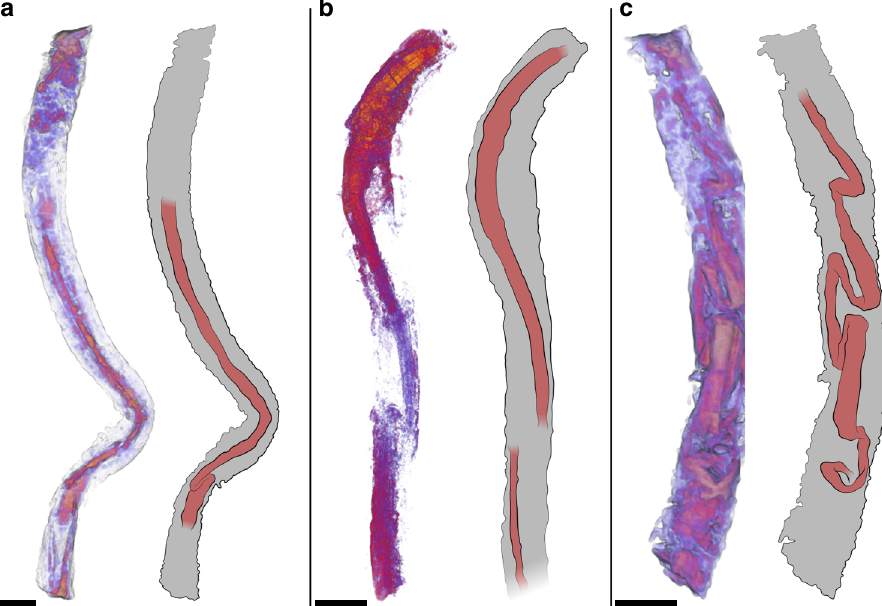
Fig. 3 Soft tissue-bearing cloudinomorphs with schematic interpretation. 3D volume render from µ CT data shown in left image per frame (red-to-orange coloration indicates high density internal regions within exterior tube), with interpretive diagram in right image per frame. Examples here show a medial position and consistency (sample USNM-N1601_FL_018), b partial degradation/fragmentation (sample USNM-E1630_006), and c kinking and folding (sample USNM-N1601_FL_017). Soft tissue in sketches highlighted in red. Samples reposited at the Smithsonian Institution. All scales = 2 mm, sketches provided by Stacy Turpin